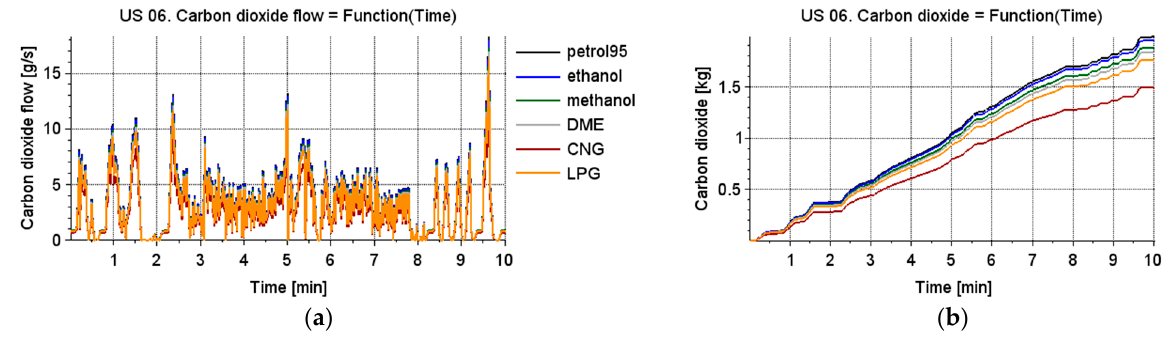
Figure 10. Results of the simulation of the stream and final fuel consumption for selected driving tests and selected fuels for the Toyota Camry LE 2018 vehicle: ( a ) waveforms of the instantaneous values of the fuel stream powering the vehicle’s engine, obtained in the simulation of the US 06 road test; ( b ) waveforms of the instantaneous values of fuel consumption for the vehicle, obtained in the simulation of the US 06 road test; ( c ) waveforms of the instantaneous values of the fuel stream powering the vehicle’s engine, obtained in the simulation of the US highway road test; ( d ) waveforms of the instantaneous values fuel consumption values for the vehicle, obtained in the US highway test simulation; ( e ) waveforms of the instantaneous values of the fuel stream powering the vehicle’s engine, obtained in the simulation of the FTP-75 road test; ( f ) waveforms of the instantaneous values of fuel consumption for the vehicle, obtained in the simulation of the FTP-75 road test; ( g ) waveforms of the instantaneous values of the fuel stream powering the vehicle’s engine, obtained in the simulation of the New European Driving Cycle (NEDC) road test; ( h ) waveforms of the instantaneous values of fuel consumption for the vehicle, obtained in the simulation of the NEDC road test; ( i ) waveforms of the instantaneous values of the fuel stream powering the vehicle’s engine, obtained in the simulation of the US SC03 road test; ( j ) waveforms of the instantaneous values of fuel consumption for the vehicle, obtained in the simulation of the US SC03 road test; ( k ) waveforms of the instantaneous values of the fuel stream powering the vehicle’s engine, obtained in the simulation of the Random Cycle Low (×05) road test; ( l ) waveforms of the instantaneous values of fuel consumption for the vehicle, obtained in the simulation of the Random Cycle Low (×05) road test; ( m ) waveforms of the instantaneous values of the fuel stream powering the vehicle’s engine, obtained in the simulation of the Random Cycle High (×95) road test; ( n ) waveforms of the instantaneous values of the fuel consumption for the vehicle, obtained in the simulation of the Random Cycle High (×95) road test; ( o ) waveforms of the instantaneous values of the fuel stream powering the vehicle’s engine, obtained in the simulation of the Mobile Air Conditioning Test Procedure (MAC TP) cycle road test; ( p ) waveforms of the instantaneous values of fuel consumption for the vehicle, obtained in the simulation of the MAC TP cycle road test; ( q ) waveforms of the instantaneous values of the fuel stream powering the vehicle’s engine, obtained in the simulation of the Common Artemis Driving Cycles (CADC) road test; ( r ) waveforms of the instantaneous values of fuel consumption for the vehicle, obtained in the simulation of the CADC road test; ( s ) waveforms of the instantaneous values of the fuel stream powering the vehicle’s engine, obtained in the simulation of the CADC w/o mot road test; ( t ) waveforms of the instantaneous values of fuel consumption for the vehicle, obtained in the simulation of the CADC w/o mot road test; ( u ) waveforms of the instantaneous values of the fuel stream powering the vehicle’s engine, obtained in the simulation of the CADC shortened road test; ( v ) waveforms of the instantaneous values of fuel consumption for the vehicle, obtained in the simulation of the CADC shortened road test; ( w ) waveforms of the instantaneous values of the fuel stream powering the vehicle’s engine, obtained in the simulation of the Worldwide Harmonized Light-Duty Vehicles Test Cycles (WLTC) 3b random road test; ( x ) waveforms of the instantaneous values of fuel consumption for the vehicle, obtained in the simulation of the WLTC 3b random road test.